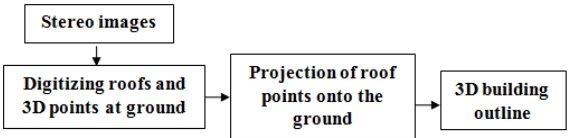
Figure 5: Flowchart of 3D building modeling from aerial images.